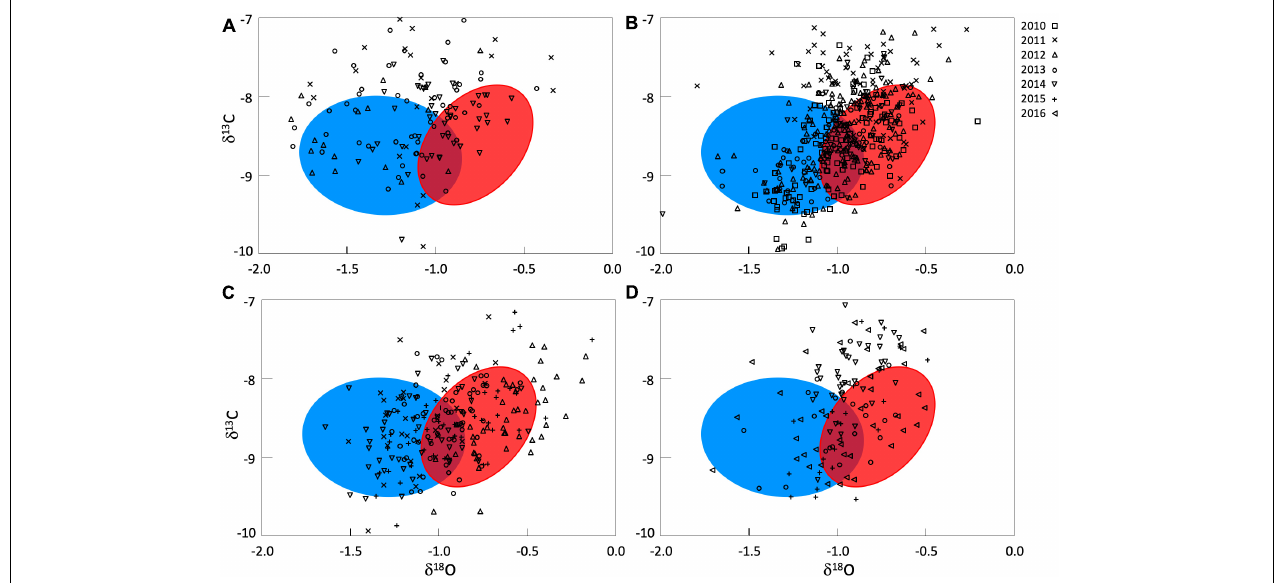
FIGURE 2 | Otolith δ 18 O and δ 13 C values for Atlantic bluefin tuna of unknown origin collected from four locations from 2010 to 2016: (A) Central North Atlantic Ocean- West of 45 ◦ W, (B) Central North Atlantic Ocean- East of 45 ◦ W, (C) Eastern North Atlantic Ocean off Morocco, (D) Eastern North Atlantic Ocean off Canary Islands. Confidence ellipses shown are based on otolith δ 18 O and δ 13 C values of yearling Atlantic bluefin tuna (baseline) and represent 1 SD of the western (blue) and eastern (red) sample. Otolith δ 18 O and δ 13 C values of yearlings used to create confidence ellipses and for mixed-stock analysis from Rooker et al. (2014).